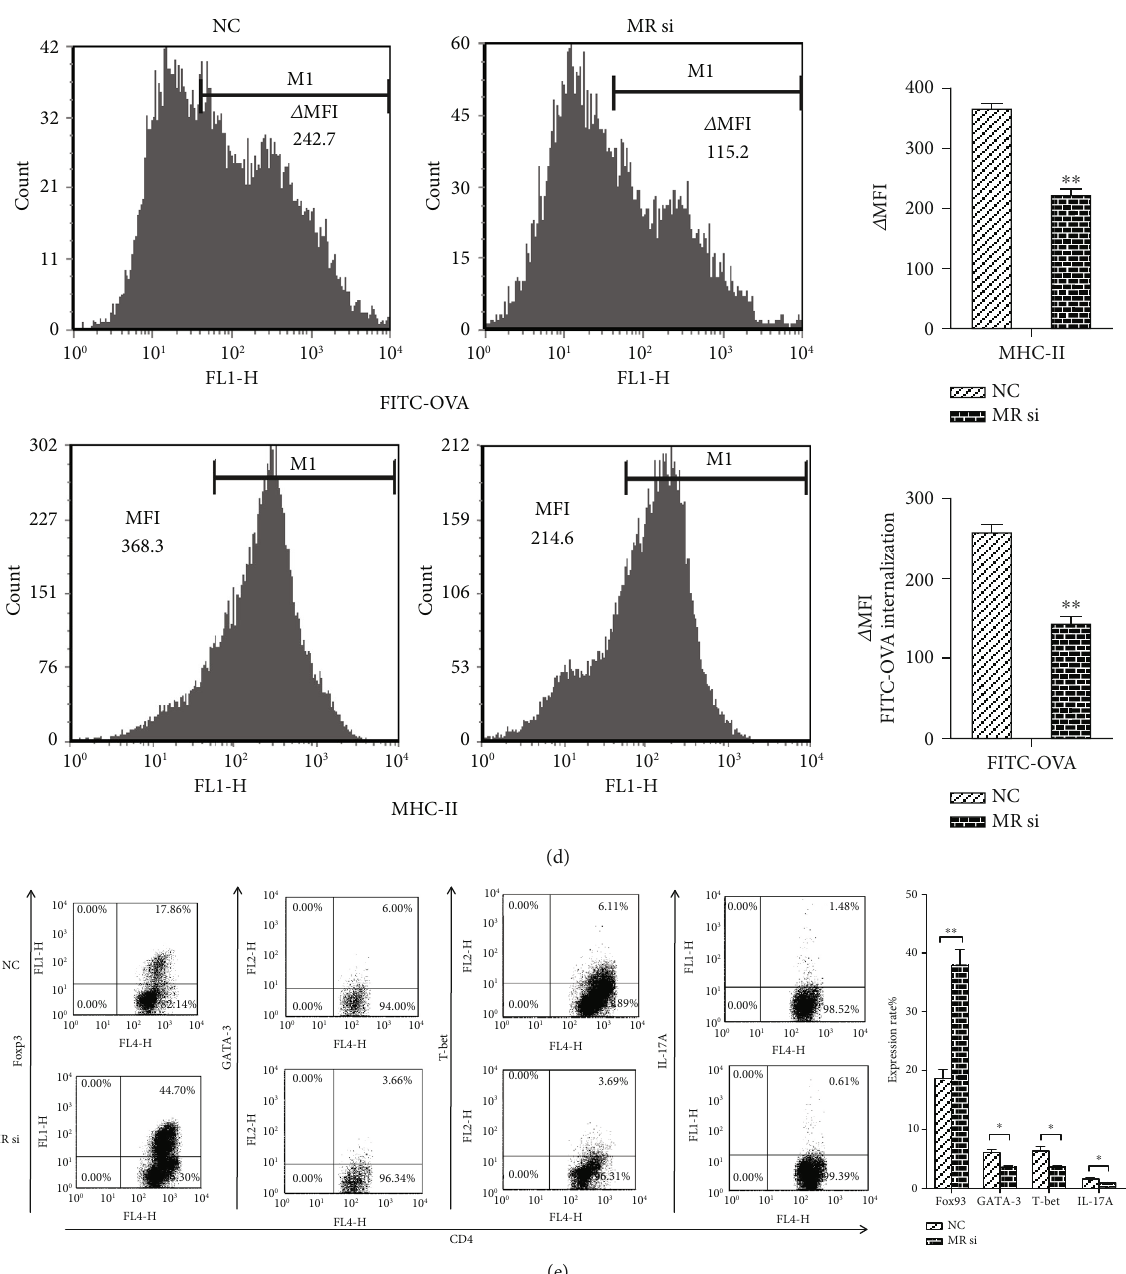
Figure 7: Mannose receptor-mediated antigen endocytosis and presentation were involved in miR-223-3p expression. (a) MR expression in DCs treated with OVA and miR-223-3p mimic or inhibitor was determined by Western blot. (b) Mouse immature DCs were transfected with siRNA-MR or siRNA control (50 nM) for 24h, and the expression of miR-223-3p was detected by qRT-PCR. (c) Mouse immature DCs were transfected with siRNA-MR, siRNA-Rhob, or siRNA control (50 nM). After 24h, DCs were stimulated with 100 μ g/ml OVA for 24h. Cell lysates were subjected to Western blot for the mannose receptor, Rhob, and GAPDH. (d – f) Mouse immature DCs were transfected with siRNA-MR or siRNA control at a fi nal concentration of 50 nM for 24h. (d) DCs were incubated with FITC-OVA for 30 minutes, and the endocytic activity (FITC-OVA uptake) of BMDCs was measured by fl ow cytometry. For determining the MHC-II level, DCs were stimulated with 100 μ g/ml OVA for 24 h and then stained with MHC-II antibody, followed by fl ow cytometry analysis. (e) The transfected DCs were stimulated with 100 μ g/ml OVA for 24h. Puri fi ed CD4+ T cells were cocultured with the transfected DCs at a ratio of 1:10 (DC/T cells). After 4 d, cells were collected and stained with anti-CD4-APC, followed by intracellular staining with FITC-conjugated anti- Foxp3, FITC-conjugated anti-IL-17A, PE-conjugated anti-GATA-3, or PE-conjugated anti-T-bet, respectively. The cells were then analyzed by fl ow cytometry. The bar chart indicated the speci fi c transcription factor of T cells in the gate of CD4+ cells in each group. Data were presented as mean ± SD of three independent experiments. t -test, ∗ P < 0 : 05 , ∗∗ P < 0 : 01